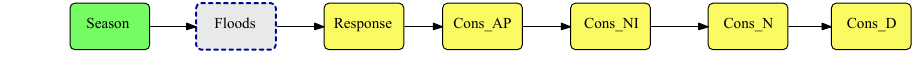
Figure 5. Risk model architecture for the case study of Oliva using iPresas UrbanSimp software tool. Table 4. Summary of land use types for the case study (non-urbanized areas were also analysed but not included in this table).